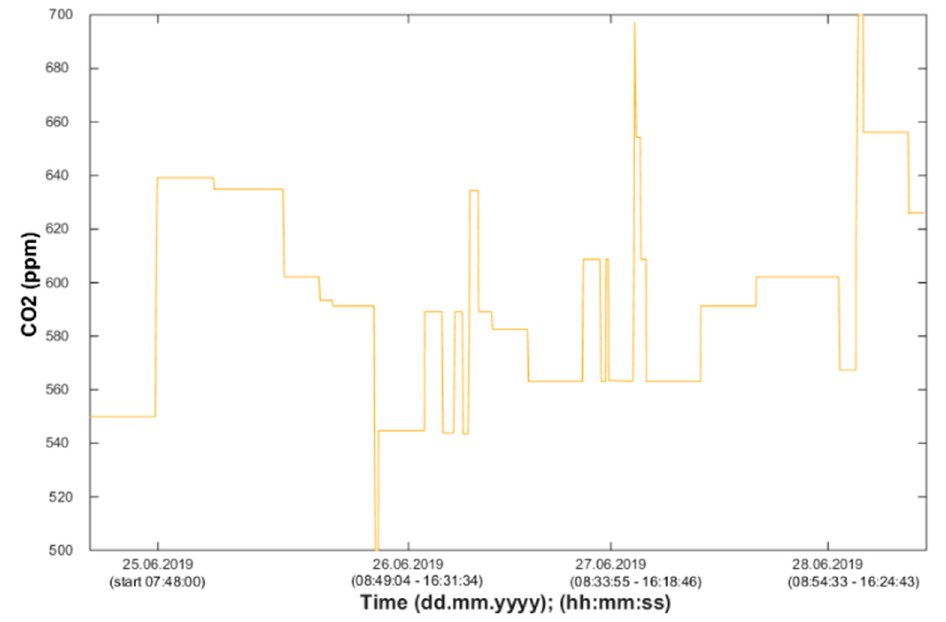
Figure 15. Waveforms of the CO 2 concentration values measured in SH room R203 (BT 12.10). Sensors 2020 , 20 , x FOR PEER REVIEW